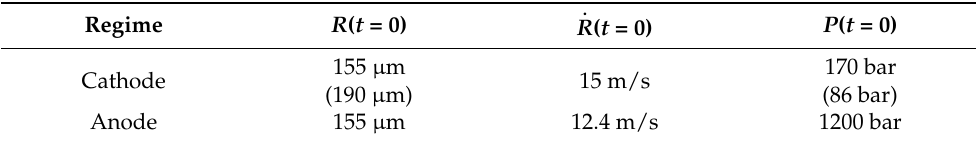
Table 1. Model parameters for modified RP